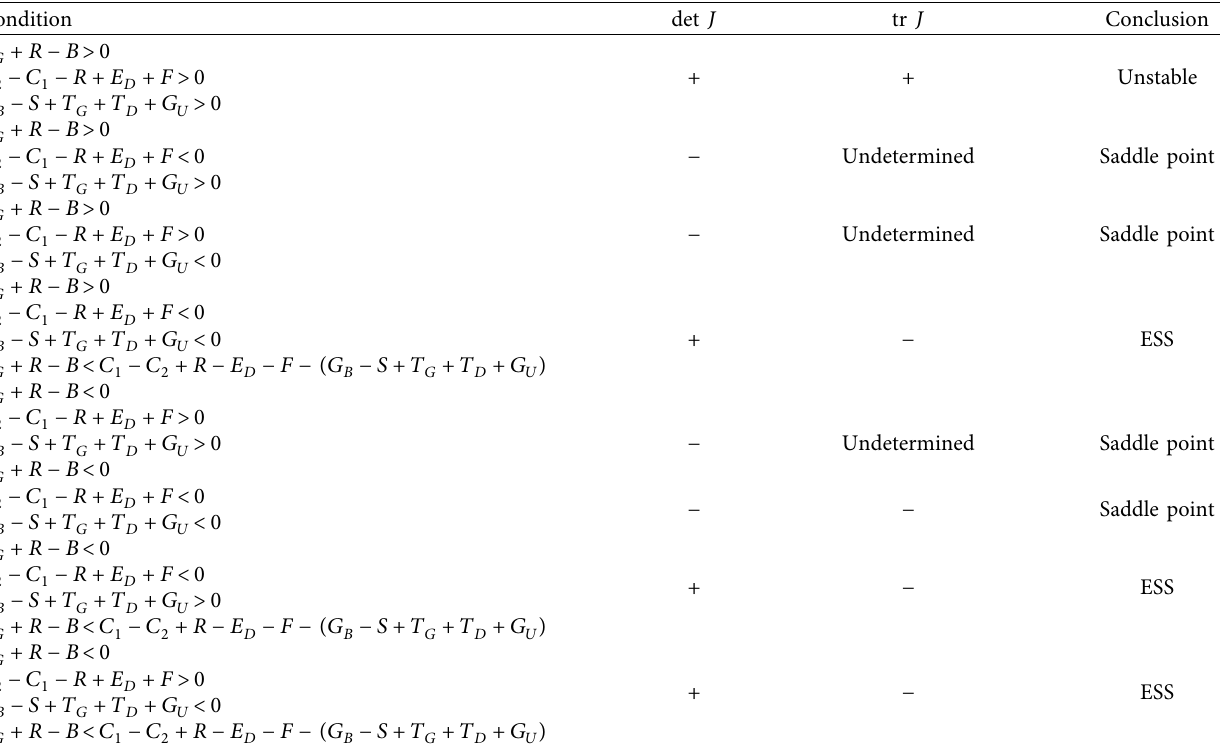
Table 4: Stability discussion of point E (1, 1,